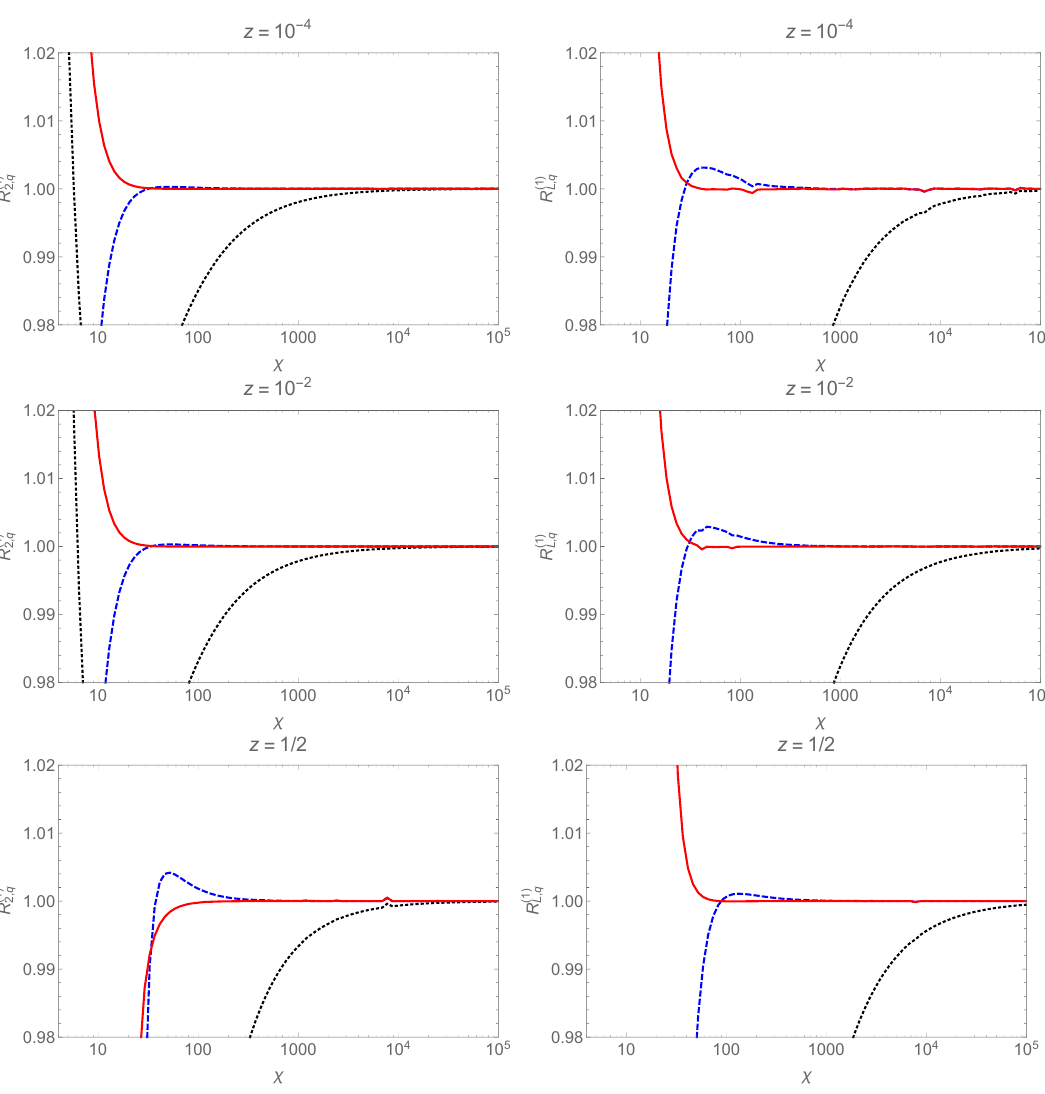
Figure 1: The ratios of the power expanded structure function to the complete structure ( 1 ) ( 1 ) (left) and R (right), as a function of χ = 1 /κ = Q 2 / m 2 function, R L , q 2, q of z gradually improved with κ suppressed terms. Dotted lines: asymptotic result; dashed / Q 2 ) improved; solid lines : O (( m 2 / Q 2 ) 2 ) improved. From Ref. lines: O ( m 2 q q